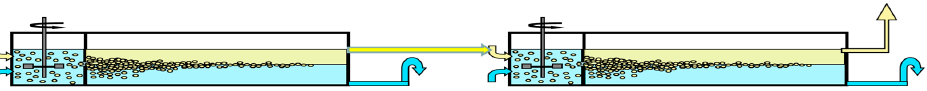
Figure 2. Two mixer-se tt lers operating in pseudo-liquid membrane mode. Column extractors are used in the chemical industry for the separation and puri fi ca- tion of organic and inorganic compounds from process solutions and industrial wastewater treatment. These apparatuses can be divided into two groups: (1) columns with an external energy input, in which kinetic energy is supplied with agitators of vari- ous types for dispersion of one of the phases (dispersed) in the volume of the other (con- tinuous) and (2) columns without energy input. In the apparatuses of the fi rst group, suf- fi cient interfacial area is provided, and interphase mass transfer is enhanced by the energy supply.